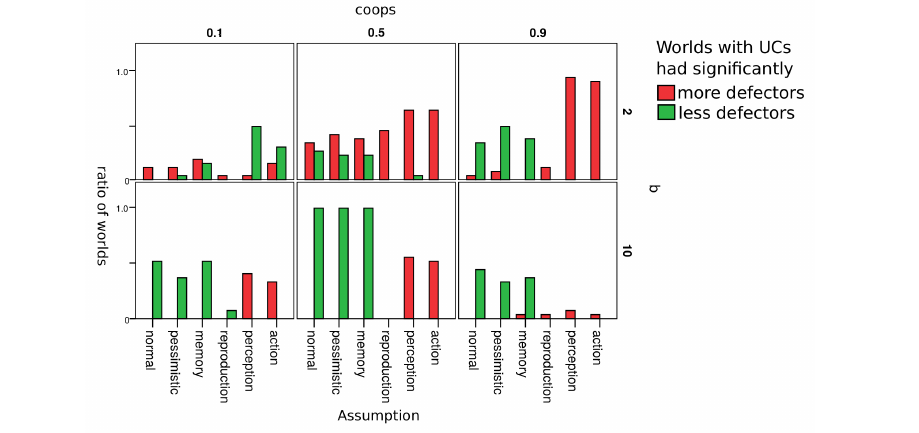
Figure 5. Ratio of worlds where the number of defectors was different in worlds with and without